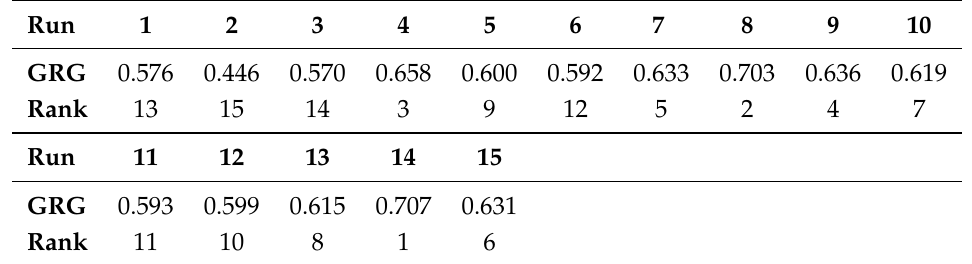
Table 8. Computed values of the grey relational grade (GRG) and